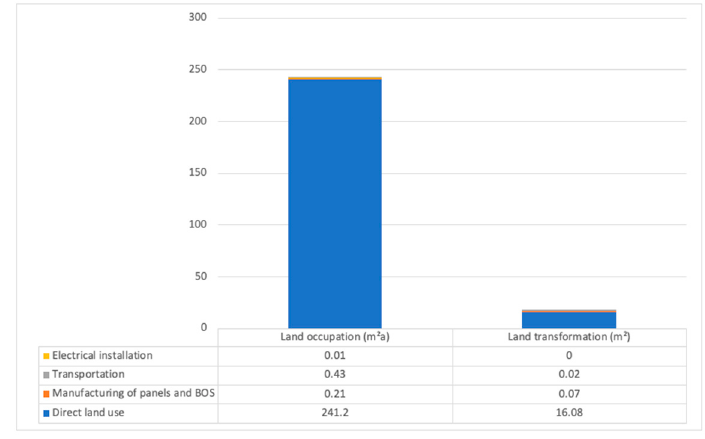
Figure 1. Life-cycle land-use requirement for SPPs in Vietnam by processes.